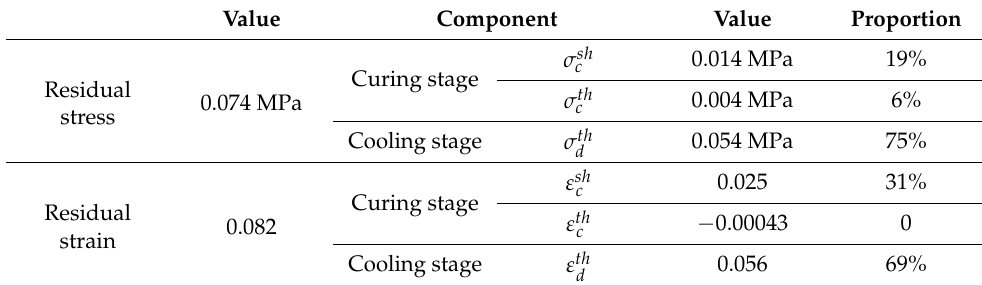
Table 3. The proportion of residual stress and strain components.